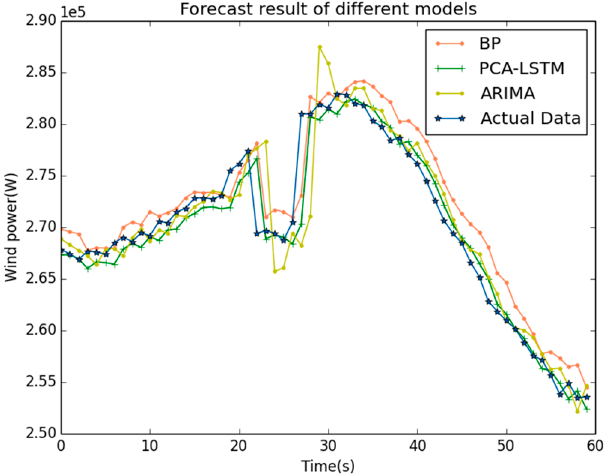
Figure 11. Prediction results between PCA-LSTM and ARIMA.